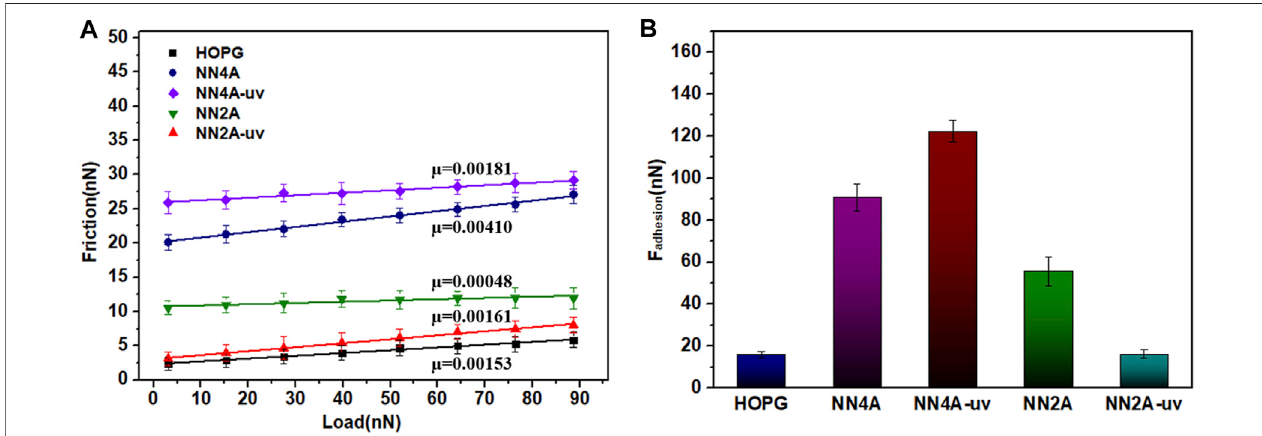
FIGURE 3 | The relationship curves of (A) Lateral force (Friction)-load; (B) F adhesion measured by AFM. The irradiation time of UV lamp with 360 nm is 40 min, and the power is 8 W/m.